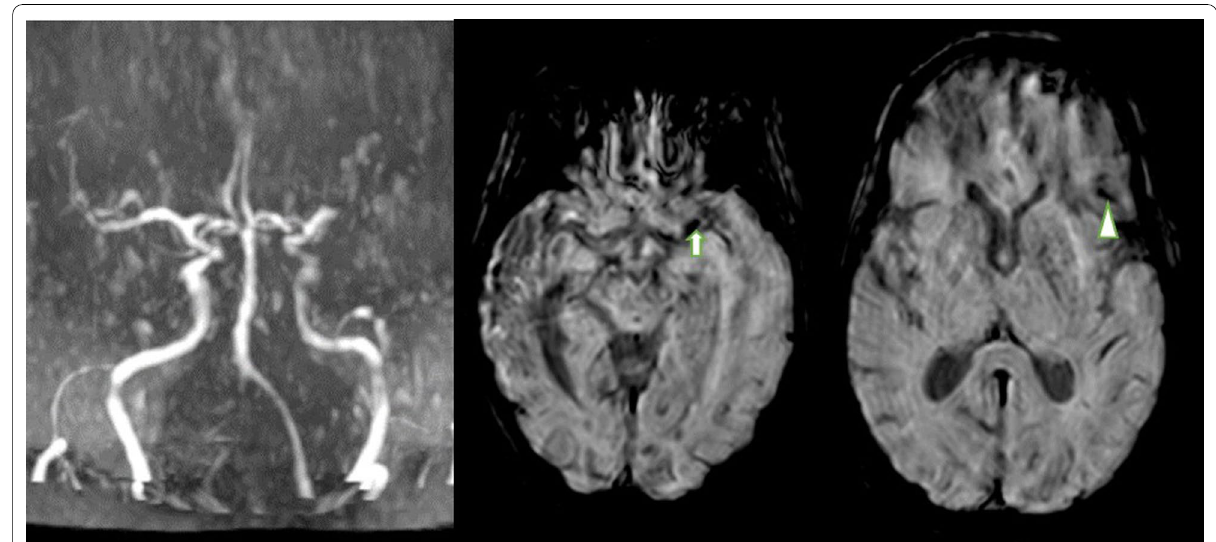
Fig. 1 An 61-year-old woman. MRA a shows abrupt interruption of left MCA at the level of M1 segment, SWI b , c shows two susceptibility vessel sign along M1 (white arrow) and M3 (arrow head) segments of left MCA representing two thrombi